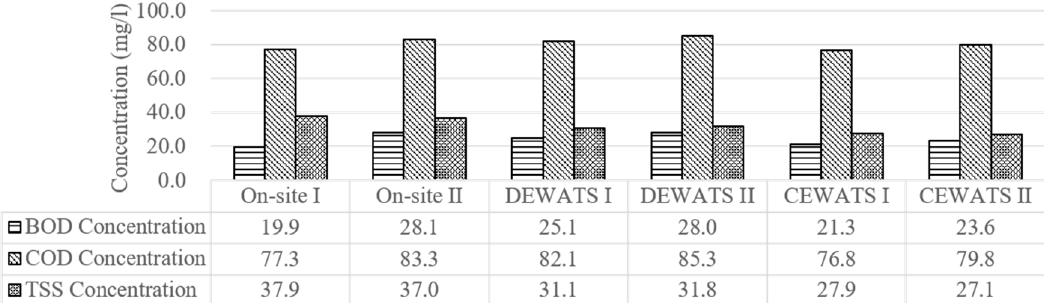
Figure 5. Simulated effluent concentrations of biochemical oxygen demand (BOD), chemical oxygen demand (COD), and total suspended solids (TSS) by BioWin for the six wastewater treatment models, satisfying the water pollution control standards of Laos.